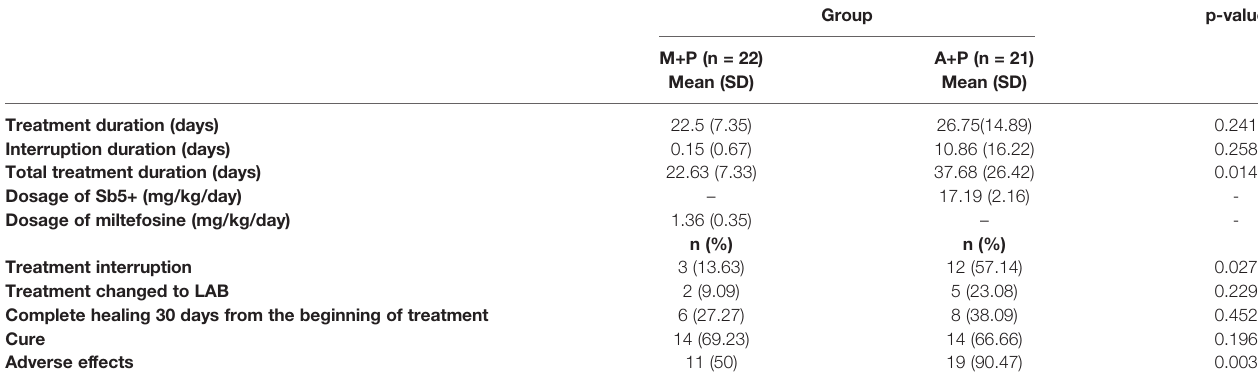
TABLE 1 | Univariate analysis of treatment outcomes.